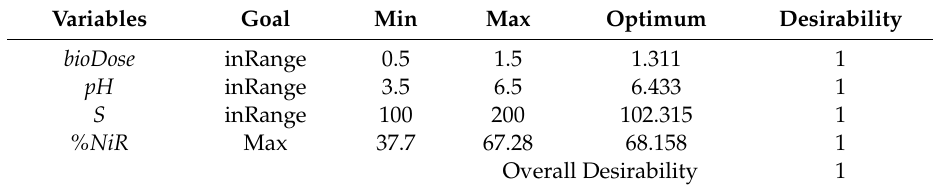
Table 10. The third biosorption optimization scenario: maximizing the Ni(II) removal e ffi